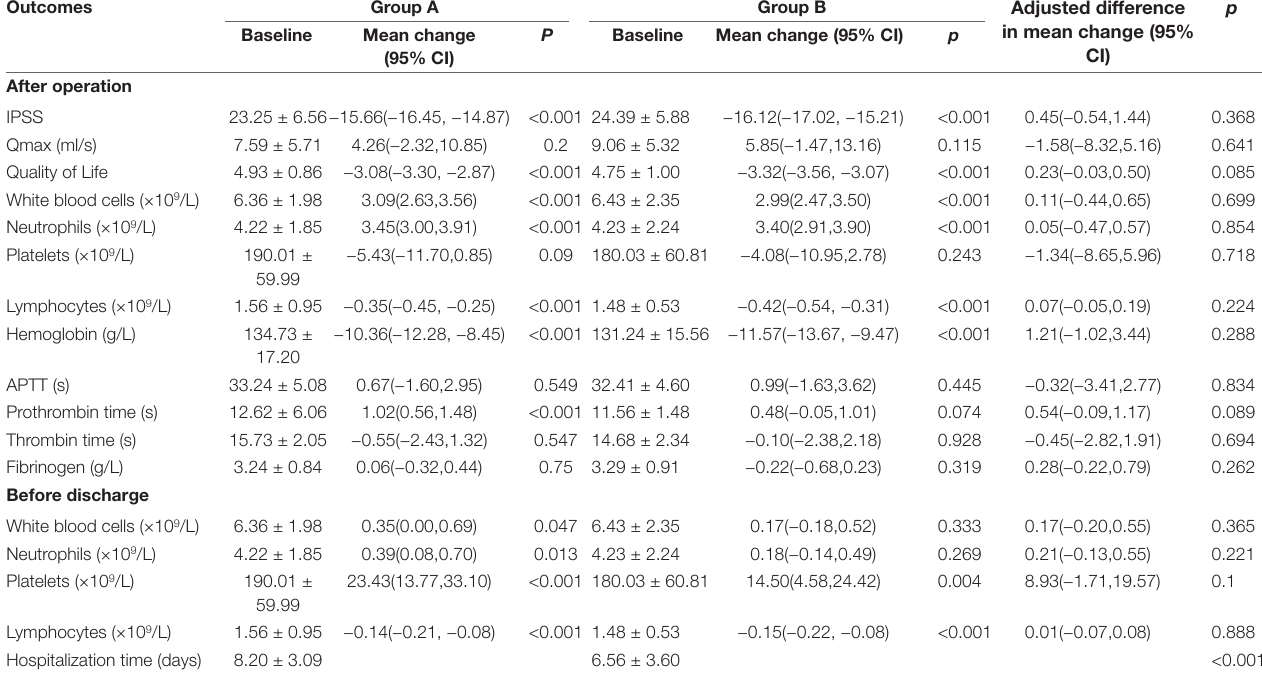
TABle 2 | Effects of Hemocoagulase Bothrops Atrox for inject on prostatic parameters and biochemical indexes in two groups. Outcomes